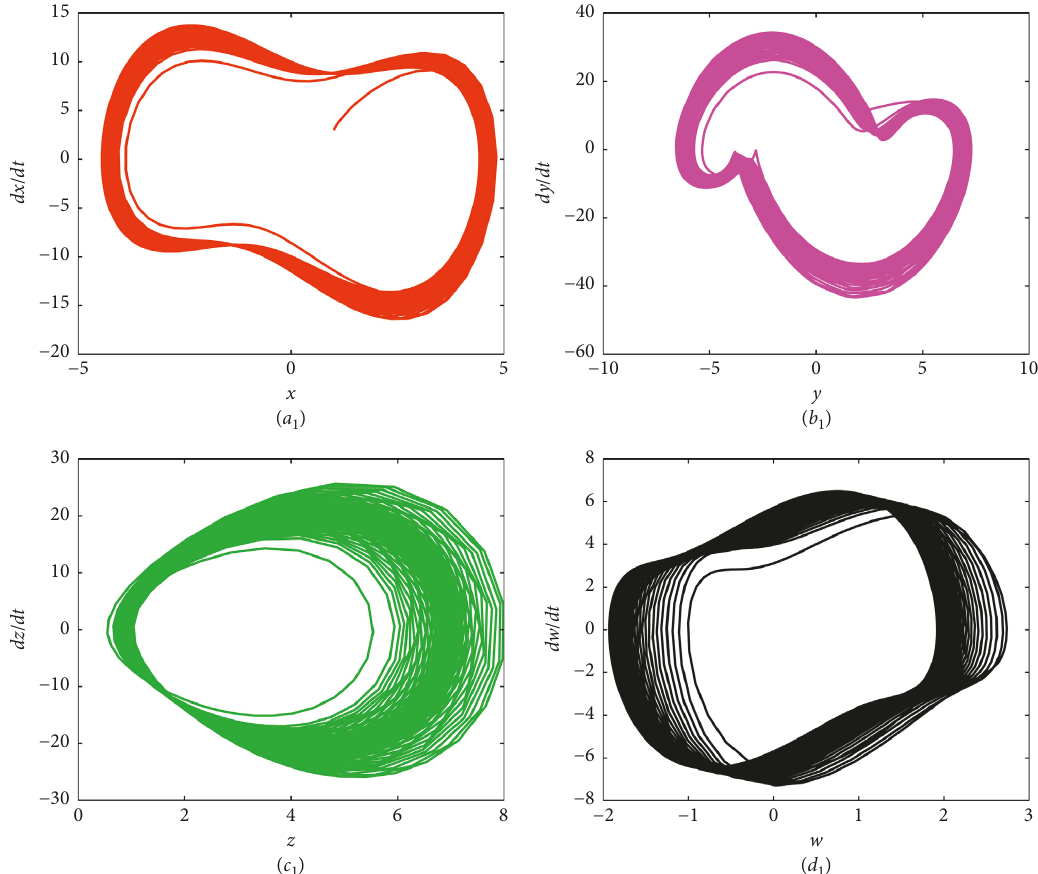
Figure 14: Phase portraits of Experiment 3 with a � 3 ,t � 3000: ( a ( d ) phase diagram of w 1